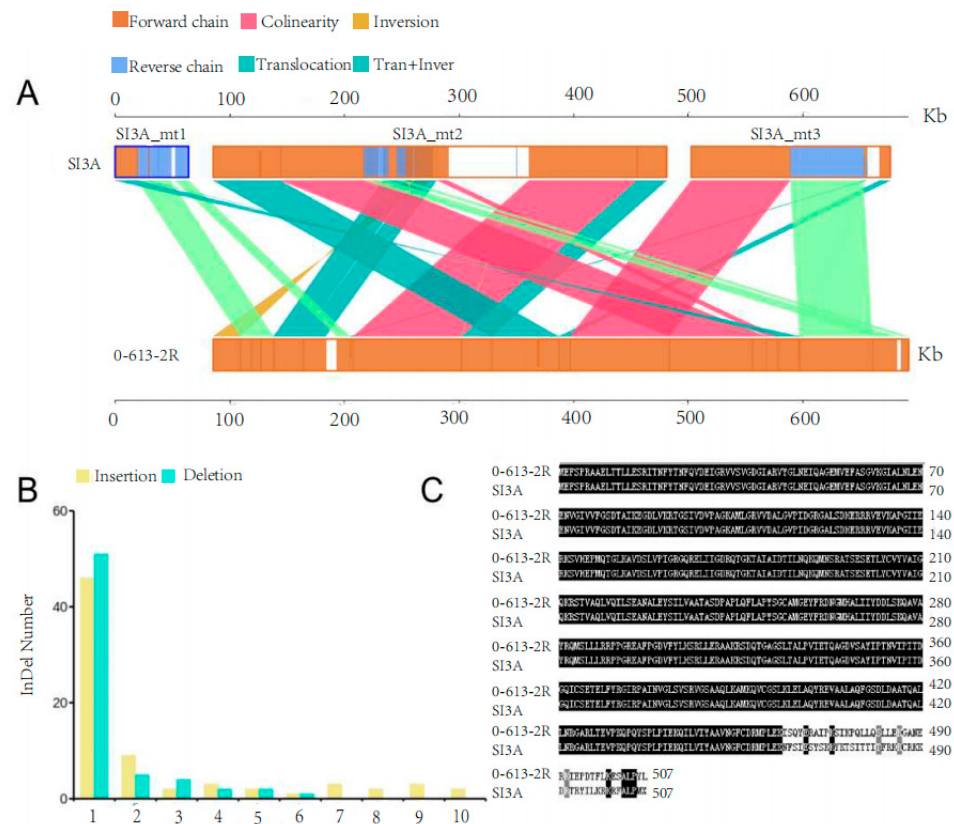
Figure 4. Structural variation and InDels number in mitochondrial genomes of SI3A and 0-613-2R. ( A ) The structural variation in SI3A and 0-613-2R. Forward chain: forward chain of the genome sequence; Reverse chain: reverse chain of the genome sequence; Collinearity: the same linear region; Tran + Inver: the area of translocation and inversion; Inversion: the area of inversion; Translocation: the area of translocation. ( B ) The length of InDels and its corresponding number in SI3A mitochondrial genome compared with 0-613-2R. Yellow, insertion; Blue, deletion. ( C ) Amino acid sequences alignment of atp1 between 0-613-2R and SI3A. Table 3. The annotation of SNP in the mitogenomes of SI3A compared with 0-613-2R. Gene